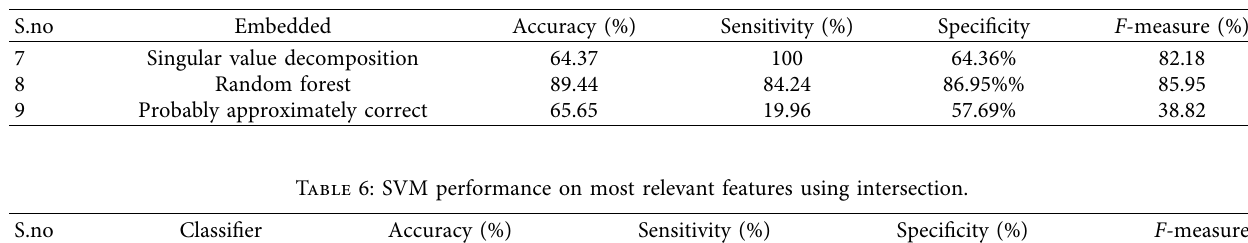
Table 5: Top 3 feature selection methods (embedded) based on high performance.